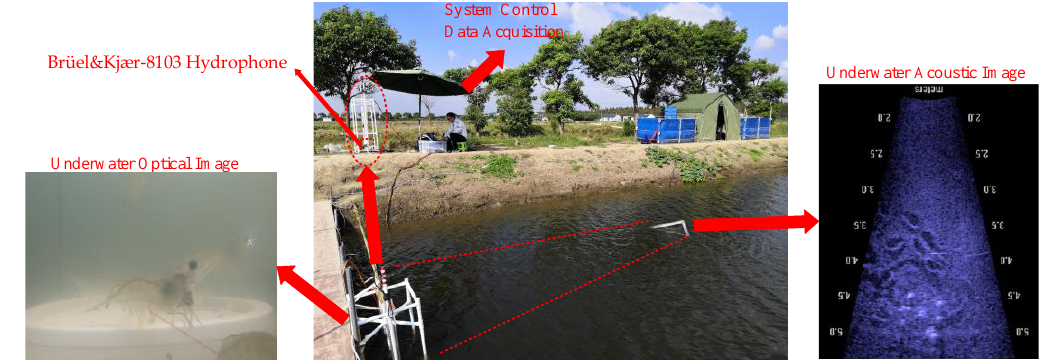
 Figure 9. Comparison of the algorithm performance at different SNRs. ( a ) The cross-correlation co- efficient curve comparison. ( b ) The SRC algorithm performance index curve. Figure 9a shows that the cross-correlation coefficients 1 r and